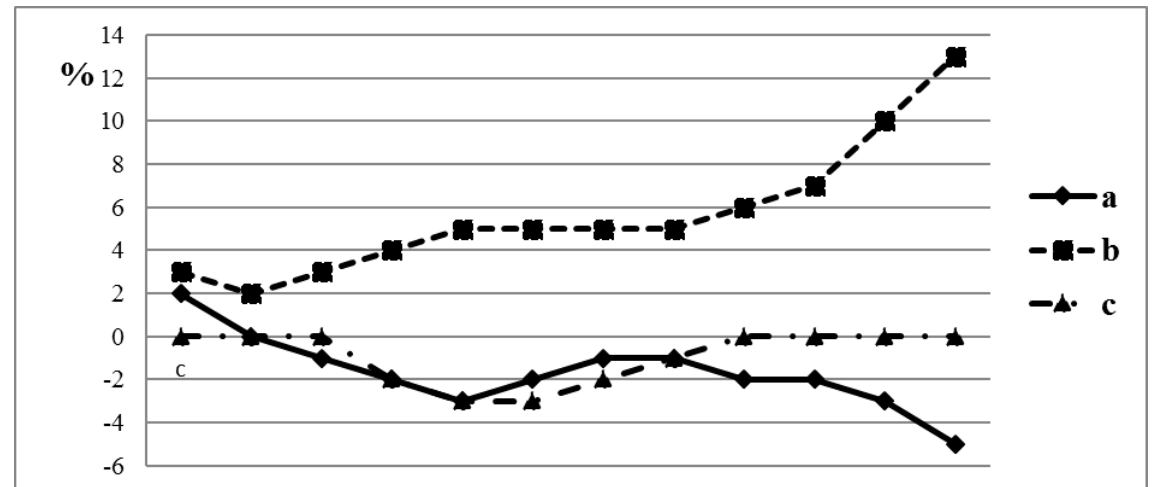
Fig. 1. Changes of pedaling velocity ( % ) of qualified cyclists in speed-power ( a ), anaerobic ( b ) and aerobic ( c ) orienta- tion.